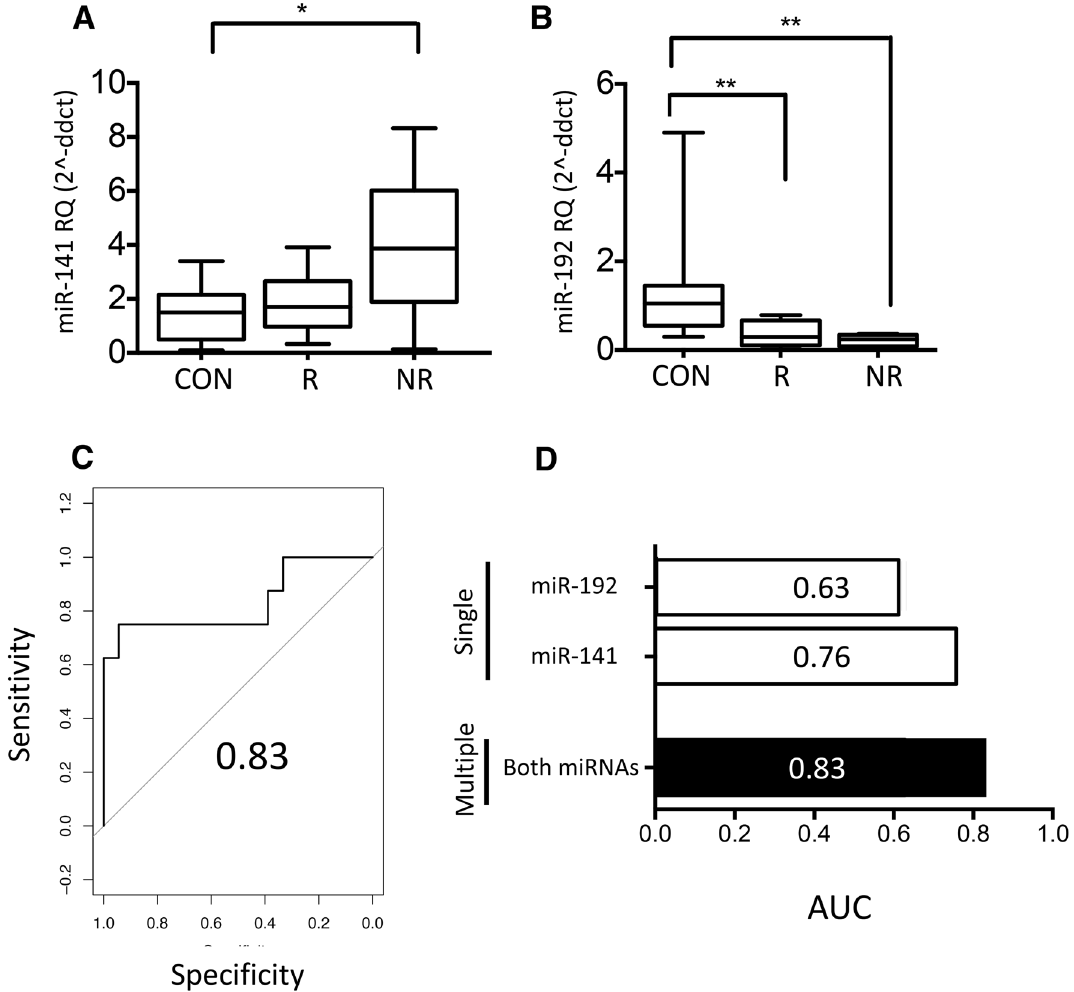
Figure 3. Elevated urinary miR-141 and decreased miR-192 are associated with AKI nonrecovery. ( A - D ) At 90 days post study entry, significant differences were observed between recovered (R; n = 18) and nonrecovered (NR; n = 8) AKI patients for ( A ) miR-141 (threefold increase) and ( B ) miR-192 (70% decrease in control compared with nonrecovered). ( C ) Receiver operating characteristic (ROC) curve for miR-141 and miR-192 area under the curve (AUC) = 0.83 in recovered compared with nonrecovered AKI patients. ( D ) Bar graph of AUCs for single and multiple miRNA comparisons between recovered and nonrecovered AKI patients. Statistical analysis comparing two groups was carried out by Mann Whitney U test, for comparison of three or more groups the Kruskal–Wallis test was used with Dunn’s multiple comparisons. Data were normalised to endogenous control miR-191 and are presented as median ± range; *p < 0.05, **p < 0.01, CON: control, R: recovered AKI patients, NR: nonrecovered AKI